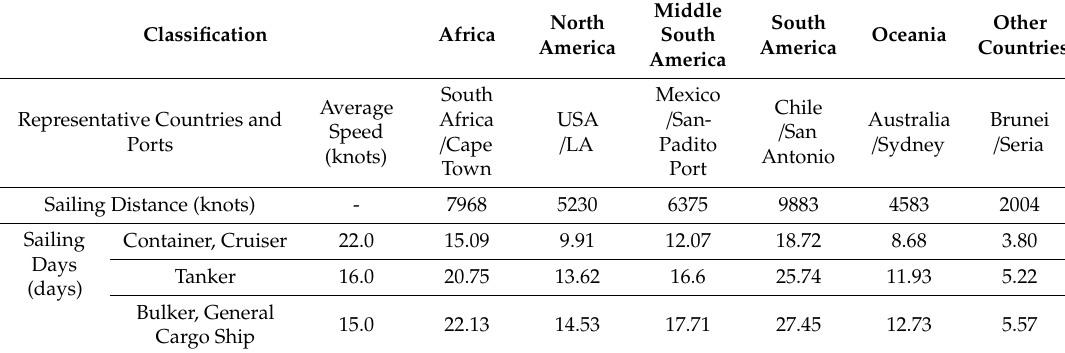
Table 14. Sailing Distance and Sailing Days of Main Area of Busan Port Origin.